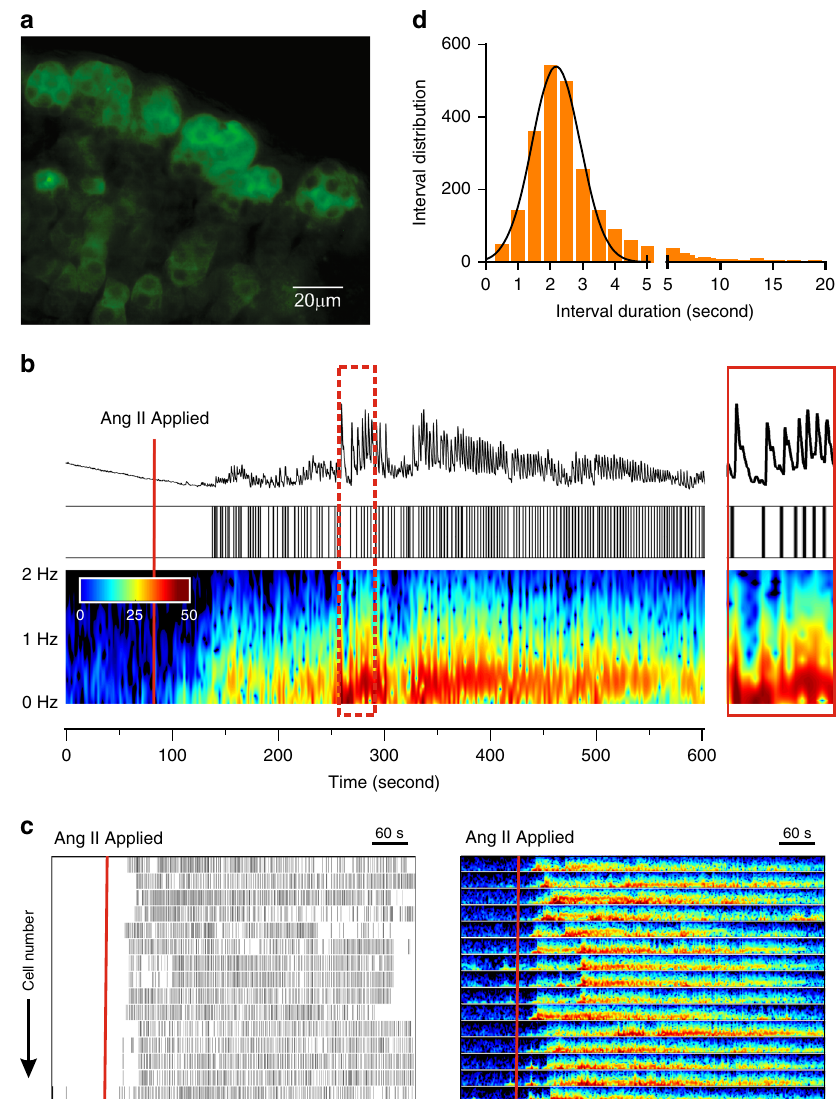
Fig. 1 Ang II-elicited calcium signaling in zG cells expressing GCaMP3. a Photomicrograph (63 × magni fi cation) of adrenal slice from a zG-GCaMP3 expressing mouse before Ang II stimulation. Individual cells within rosettes can be distinguished by their dark nucleus, surrounded by cytosolic GCaMP3. Scale bar: 20 µ m. b Representative trace of fl uorescence intensity (top) imaged in a zG cell before and after stimulation with 3 nM Ang II (red line, 90 s after start of record) and corresponding raster plot (middle) of calcium spikes captured at 20 Hz for 10 min. (bottom) Spectrogram of oscillation frequency after Fourier transformation. A magni fi cation of the region indicated by dashed red rectangle is provided on the far right. c Raster plot of calcium spikes (left) and corresponding spectrogram of oscillation frequencies (right) from all cells measured in a single adrenal slice. Solid red line indicates when 3 nM Ang II was added to the bath solution. Scale bar: 60 s. d Frequency distribution of inter-calcium spike intervals (0.1 min bins) elicited by 3 nM Ang II is normally distributed (mean ± SEM [Hz]: 0.519 ± 0.006, n = 24,052). Source data are provided as a Source Data fi